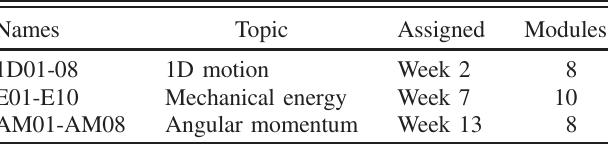
TABLE I. Sequences and modules selected for analysis in the current